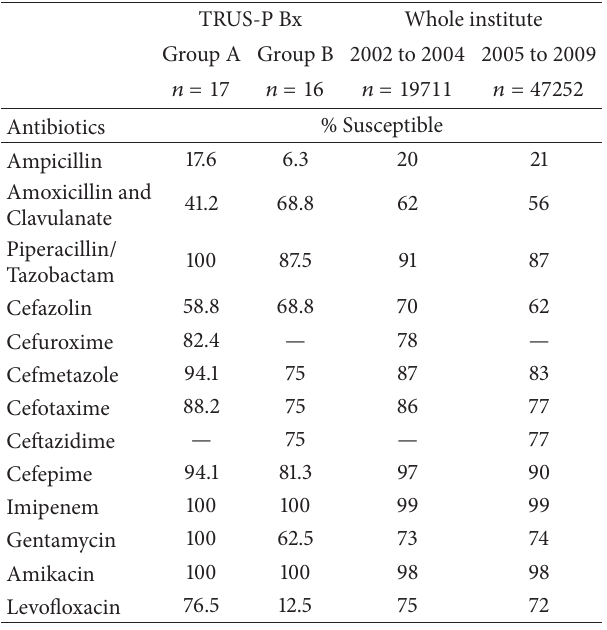
Table 4: Susceptibility of E. coli to antibiotics in infectious compli- cations and from 2002 to 2009.